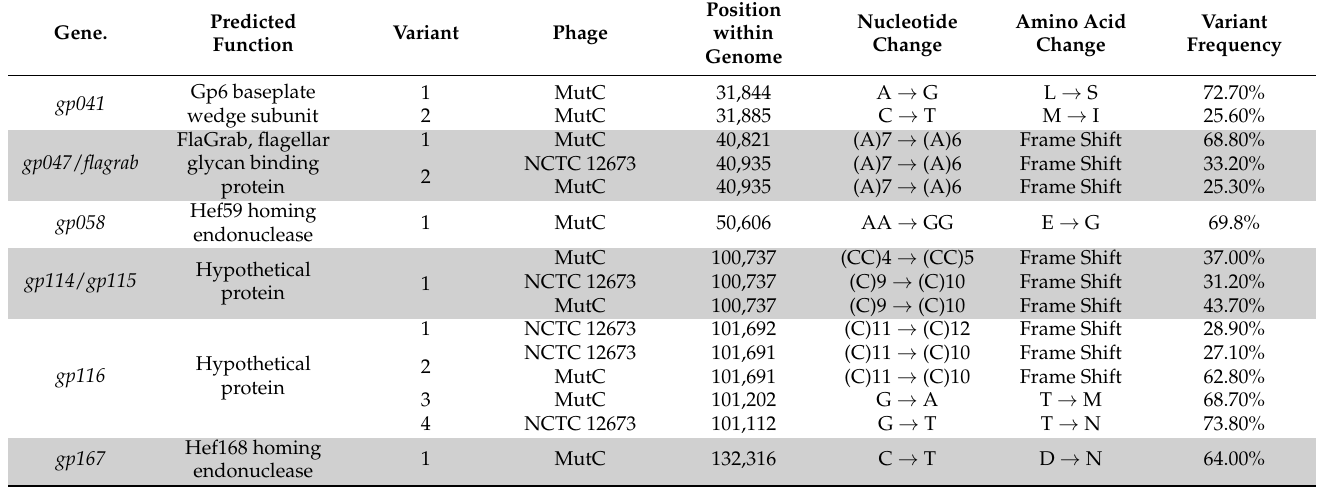
Table 2. Variant frequency table showing amino acid-level genetic differences between NCTC 12673 and MutC phages. For each gene displaying one or more variants between the two phages, the variants are listed, along with nucleotide change(s) relative to the NCTC 12673 reference strain in GenBank (accession: GU296433) [18], the corresponding amino acid change, the variant frequency, and the corresponding phage genome for each. (A)7 → (A)6: AAAAAAA → AAAAAA. gp114 / gp115 : change observed in the region where these genes